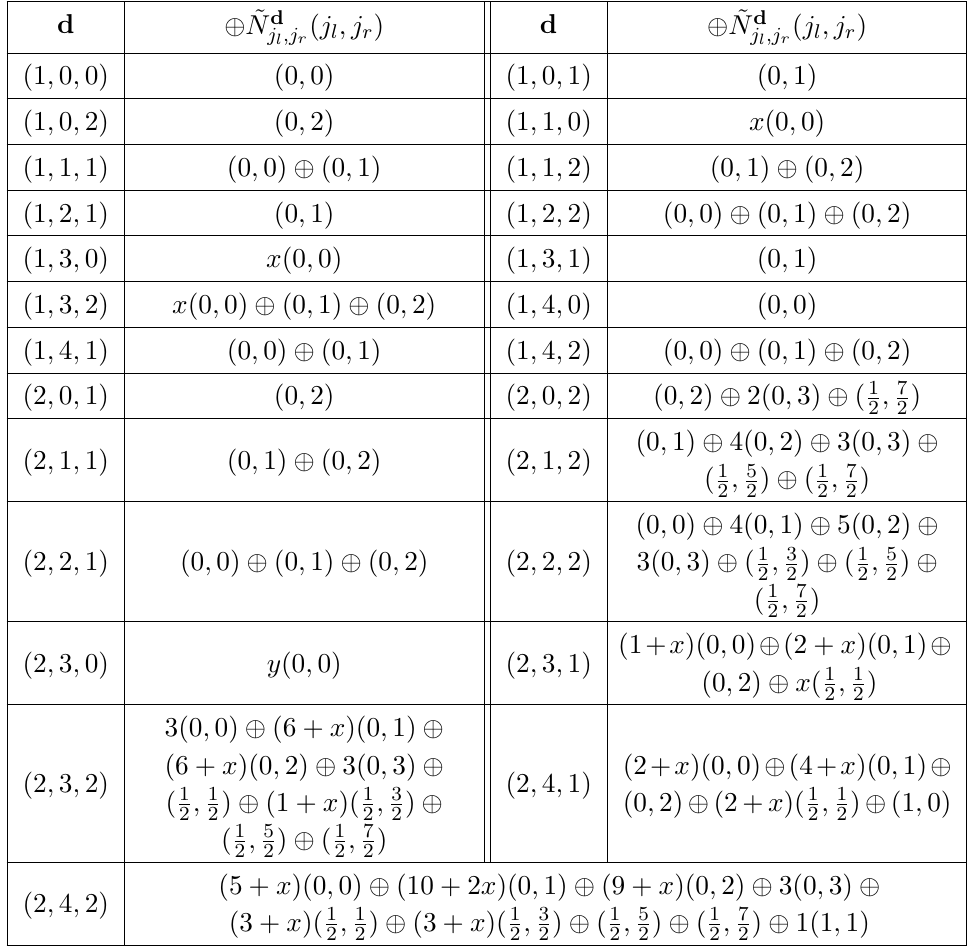
Table 20 . Spectrum of the fundamental Wilson loop operator in the SU(3) 9 theory for ( d 1 , d 2 , d 3 ) ≤ (2 , 4 , 2) . Here, d = ( d 1 , d 2 , d 3 ) labels the BPS states with fugacity Q − 1 / 3 coefficients x and y are conjectured to be